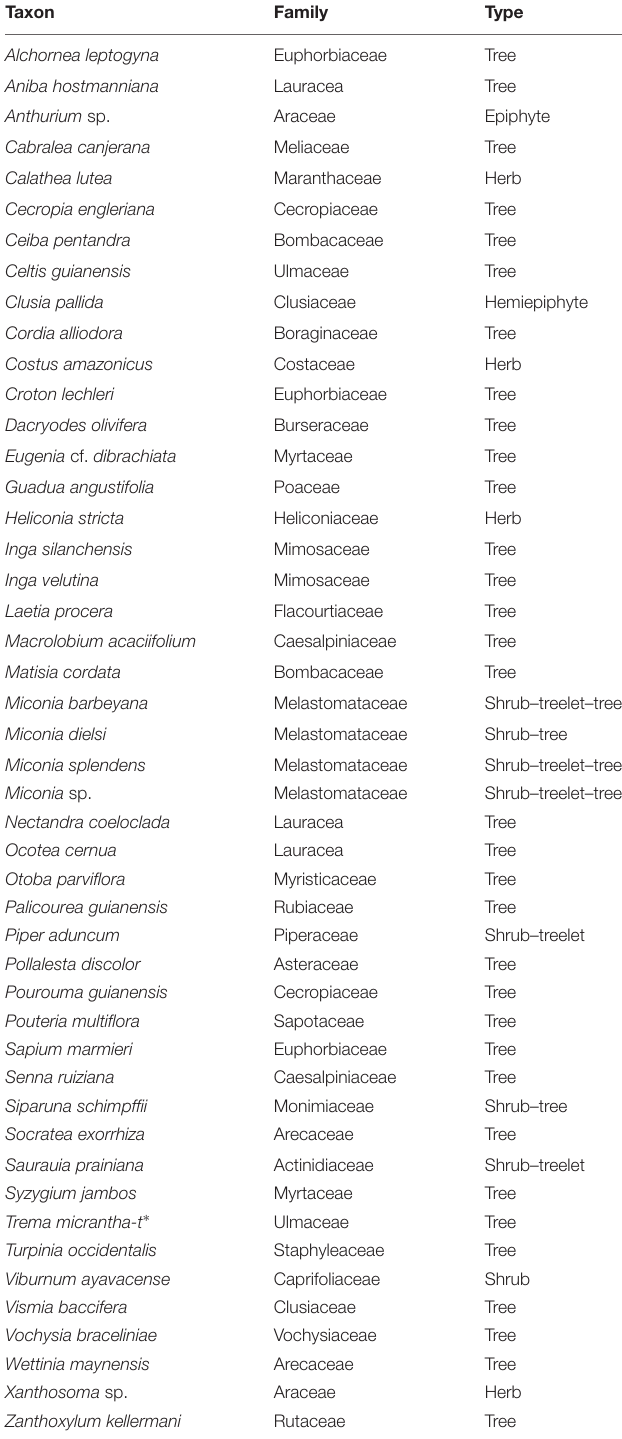
TABLE 1 | List of main vegetation taxa currently present surrounding Laguna Pindo based on rough field survey by C. X. Luzuriaga in 2013 and Luzuriaga